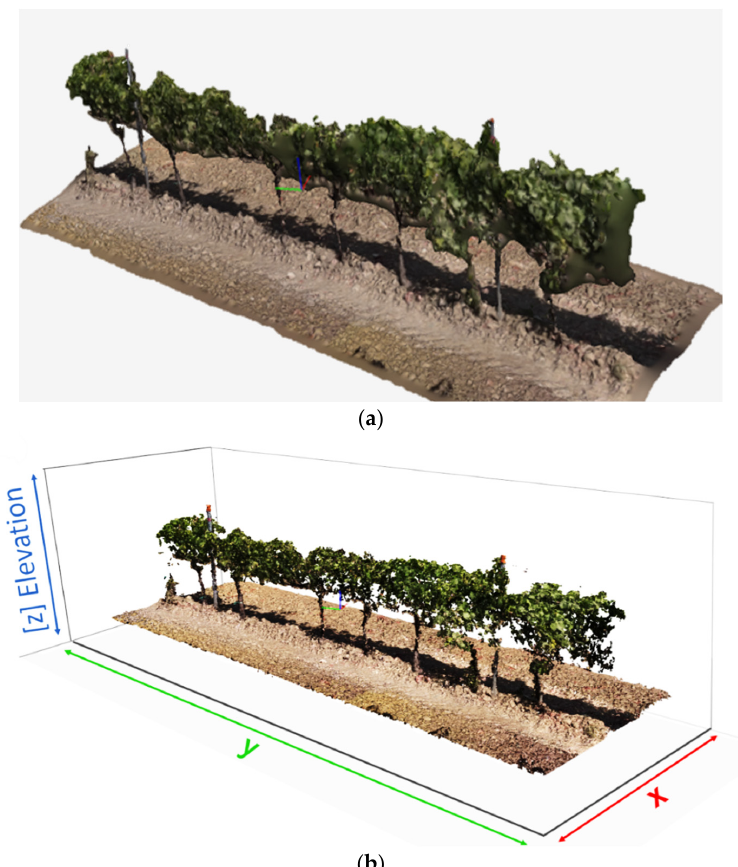
Figure 11. 3D model representation of a vineyard row processed using Agisoft Metashape Profes- sional version 1.8.4 (Agisoft LLC, St. Petersburg, Russia), ( a ) depicts a 3D solid model of the row; ( b ) depicts the result of applying the model reconstruction algorithms.